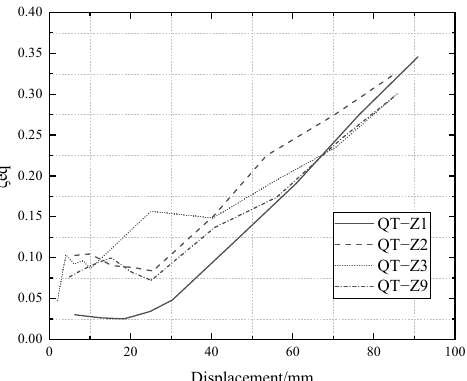
Figure 23. Equivalent viscous damping coefficient curves.